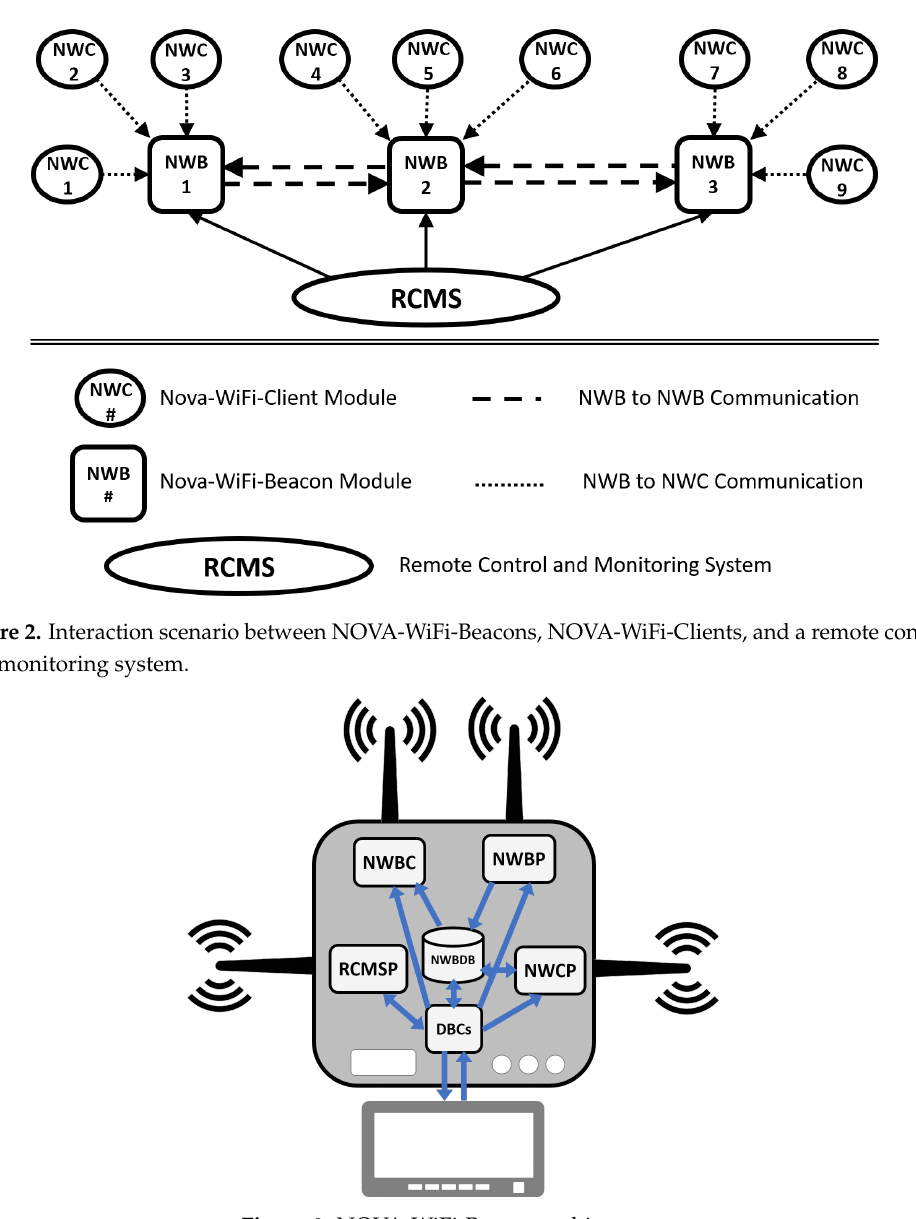
Figure 3. NOVA-WiFi-Beacon